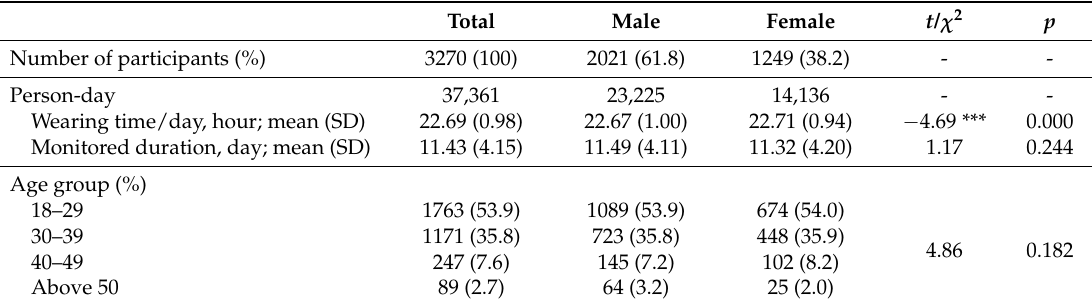
Table 1. Descriptive information of the study